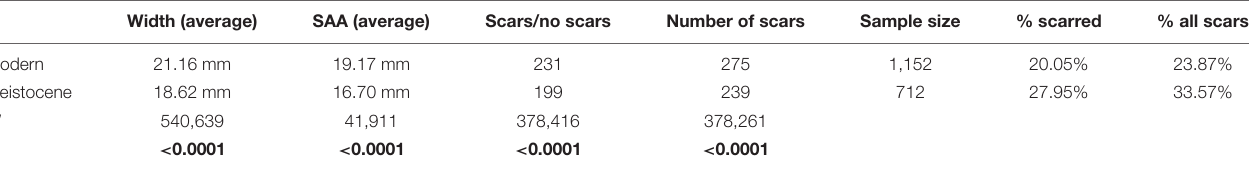
TABLE 1 | Summary data and Wilcoxon rank sum tests.